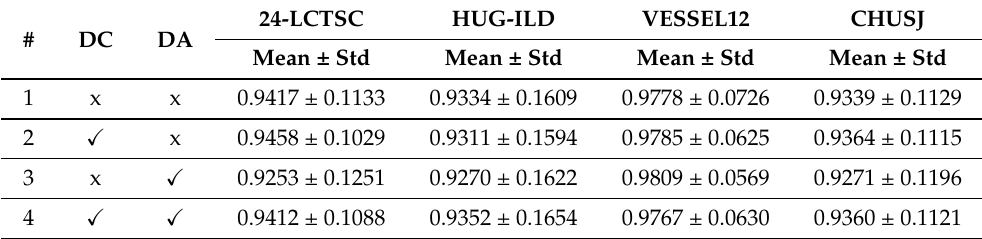
Table 3. Mean and standard deviation (std) results of the Dice similarity coefficient (DSC) for each dataset and for each experiment. For simplicity purposes a number is assigned to each experiment, as indicated in the first column, # . The DA column corresponds to the data augmentation and the DC column corresponds to the data correction. The value x in these two columns indicates experiments without DA or DC and the value (cid:88) indicates experiments with DA or DC. The values of the DSC can lie in the range 0–1.